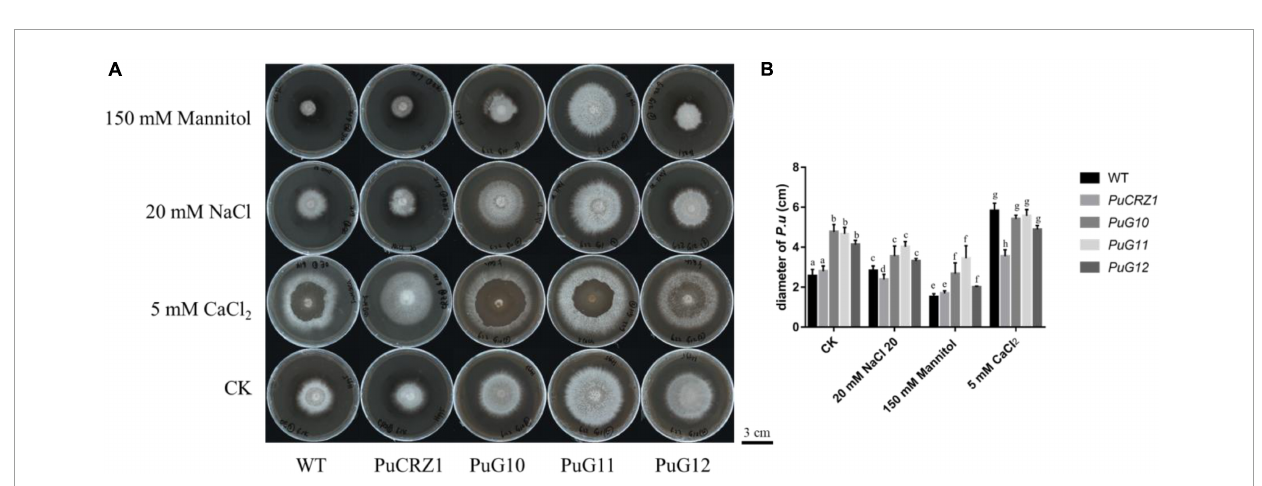
FIGURE6 Colony morphology and growth rate of wild-type P. umbellatus and transgenic P. umbellatus strains ( PuCRZ1/PuG10/PuG11/PuG12 ) under different conditions. (A) Colony morphology rate of P. umbellatus under different conditions. Bar = 3 cm. (B) Statistics of mycelial growth rate of different transgenic P. umbellatus in different medium. Columns labeled with different letters in the same medium denote a significant difference ( P < 0.05), n =